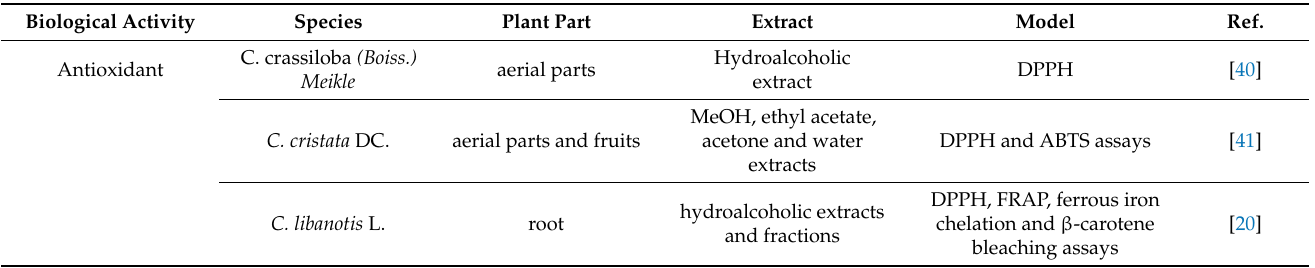
Table 3. Cachrys spp. investigated biological